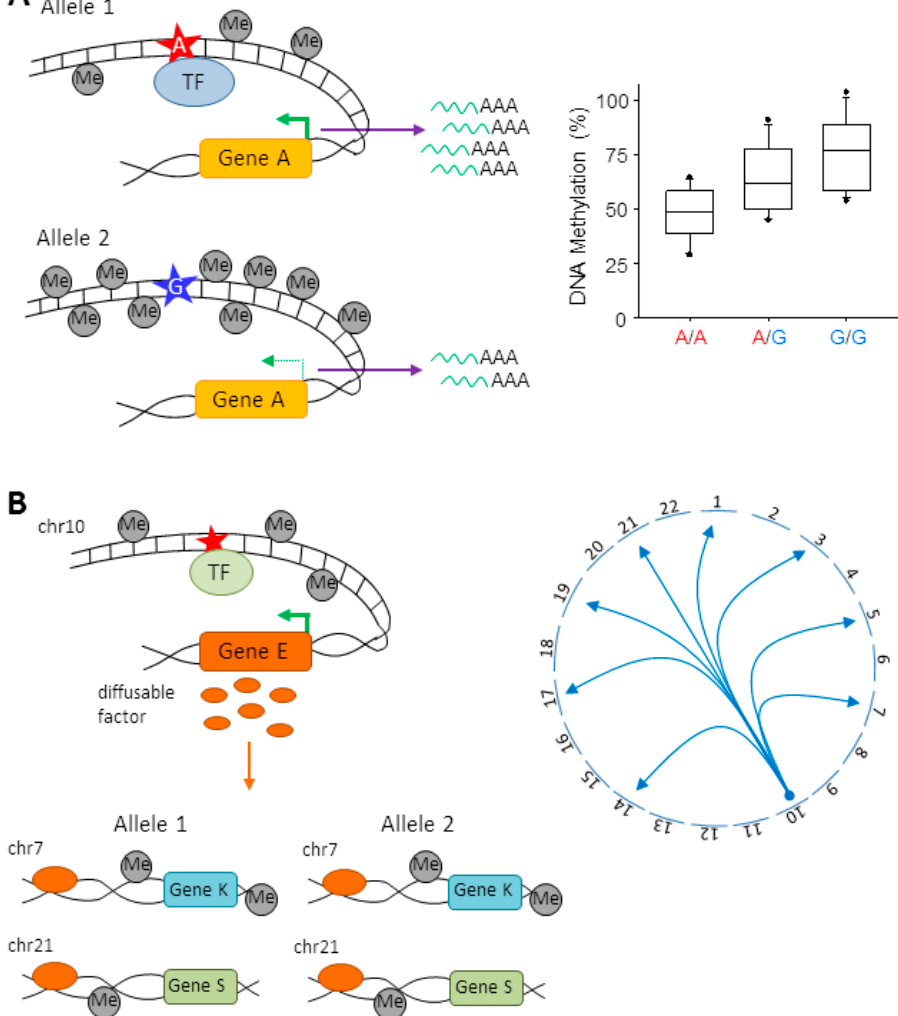
Figure 2. Model for local meQTLs: ( A ) A local cis -acting variant (A-allele symbolized by a red star) resides in a regulatory element, for example a transcription factor (TF) binding site. Sequence variation (G-allele symbolized by a blue star) can result in reduced binding of the TF, diminished transcription of gene A, and encroachment of DNA methylation ( left ). As depicted by the chart, cis -meQTLs show differences in the amount of CpG-methylation (Me) between the two copies of an allele. Homozygous carriers of the transcriptionally active A-allele show less DNA methylation when compared to homozygous carriers of the transcriptionally less active G-allele or heterozygous carriers ( right ); ( B ) Trans -meQTLs result from differences in the expression, structure, or function of a diffusible factor that is equally available to both alleles at target sites. Accordingly, target sites (genes K and S) do not show differences in allele-specific methylation rates. Trans -meQTLs can involve variation in the sequence of TF binding sites (red star) driving expression of the diffusible factor or variation in the coding sequence of the diffusible factor leading to altered structure or function ( left ). Functionally, trans -meQTLs can affect transcription levels of multiple genes. Such trans associations can be shown on a circle plot (chromosomes (chr) labeled 1–22 with arrows pointing to location of a gene on a given chromosome) ( right